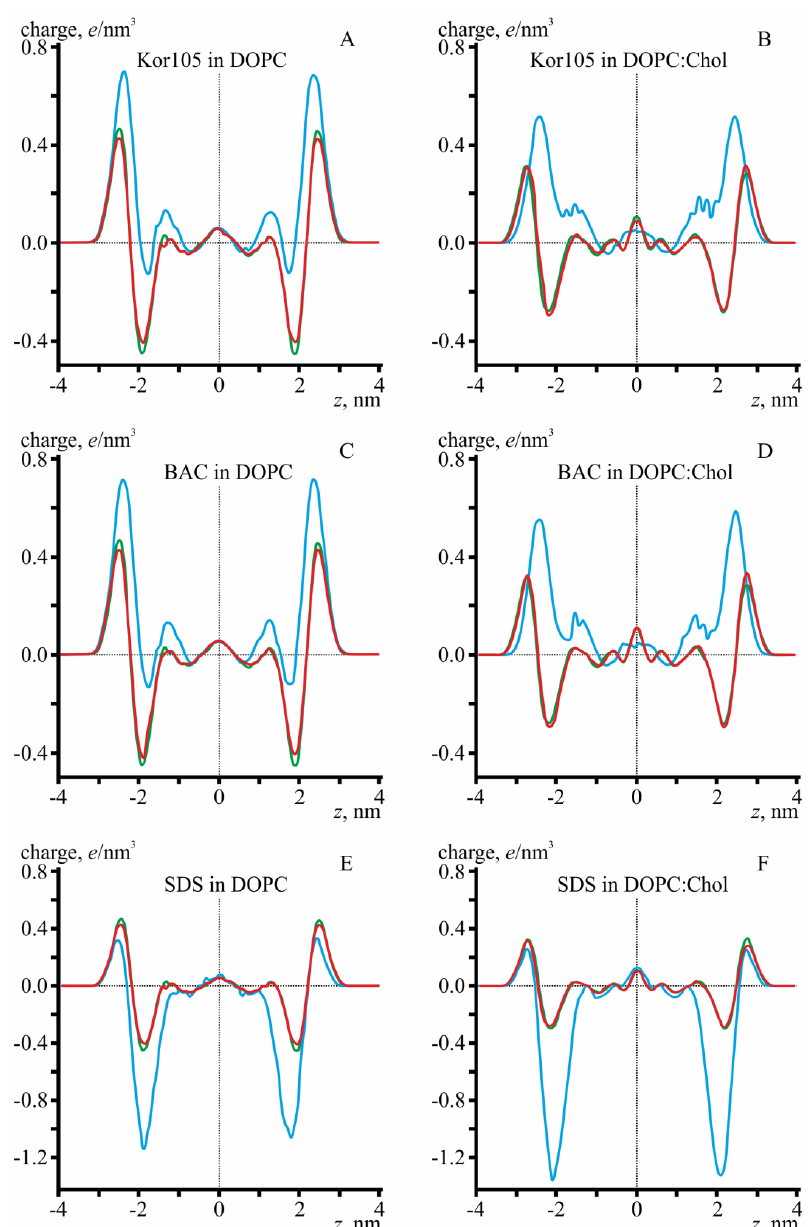
Figure 8. Distribution of the electrical charge density along the Oz axis (perpendicular to the membrane plane). Green curves are lipid membranes without hydrophobic ions, red curves are single molecules of the hydrophobic ion located in the upper monolayer (positive z ), and blue curves show high concentrations of hydrophobic ions, evenly distributed between the lipid monolayers. z = 0 corresponds to the monolayer interface (middle of the membrane). A —Kor105 in the DOPC membrane; B —Kor105 in the DOPC / Chol 3:2 membrane; C —BAC in the DOPC membrane; D —BAC in the DOPC / Chol 3:2 membrane; E —SDS in the DOPC membrane; F —SDS in the DOPC / Chol 3:2 membrane.